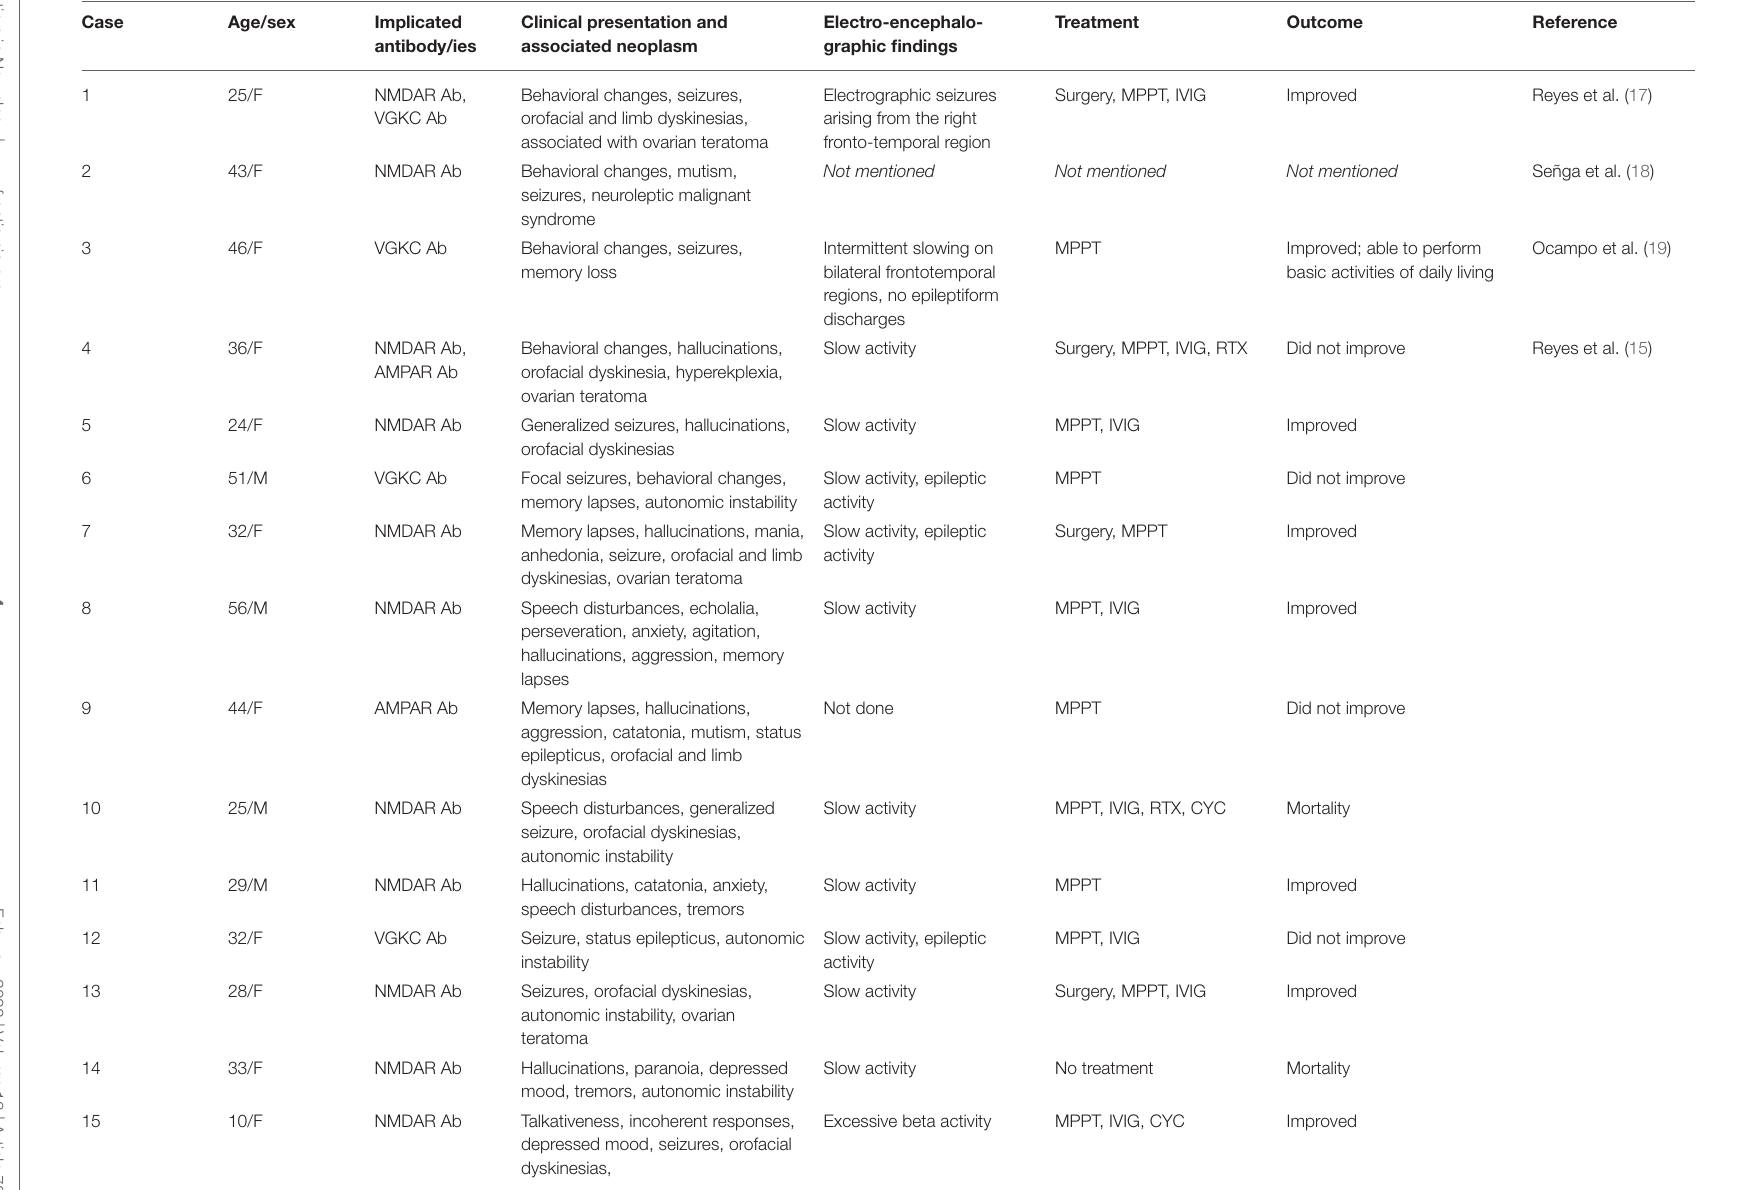
TABLE 1 | Summary of clinical profile and outcomes of identified autoimmune encephalitis cases in the Philippines from published data.